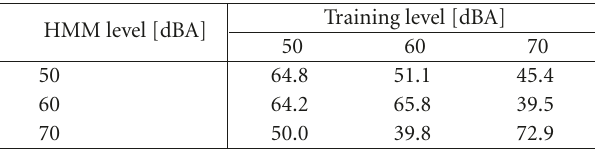
Table 2: Lombard nonaudible murmur recognition using matched and crossed models.